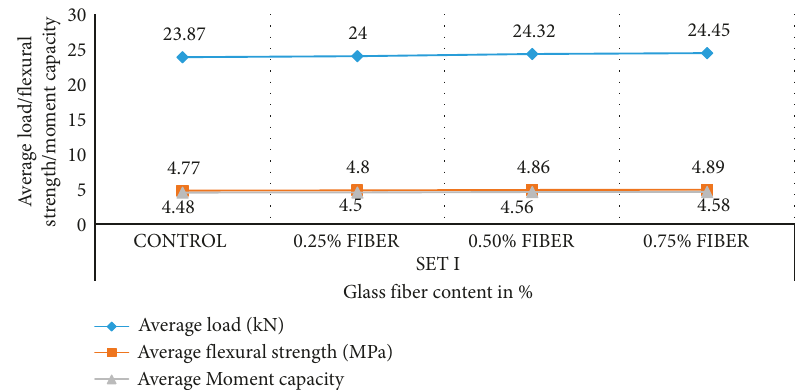
Figure 7: Average load/flexural strength/moment capacity versus glass fiber content on 28th day.